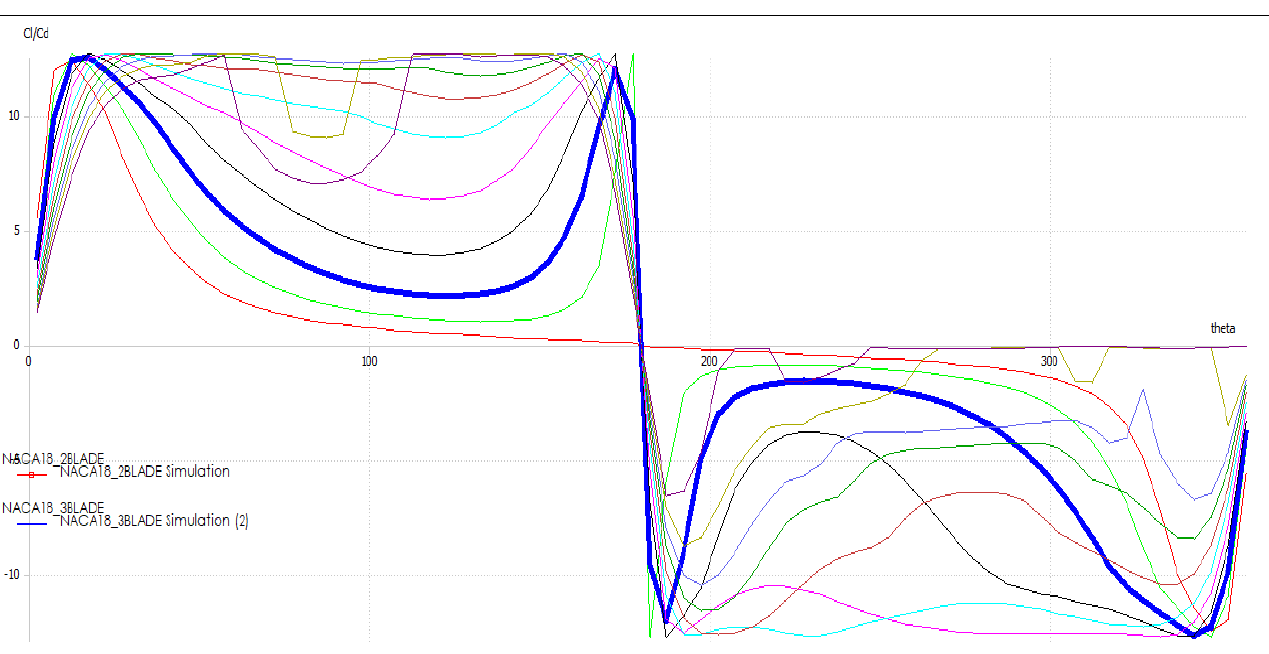
Figure 27. Cl/Cd vs theta plot of mid-section for TSR 2